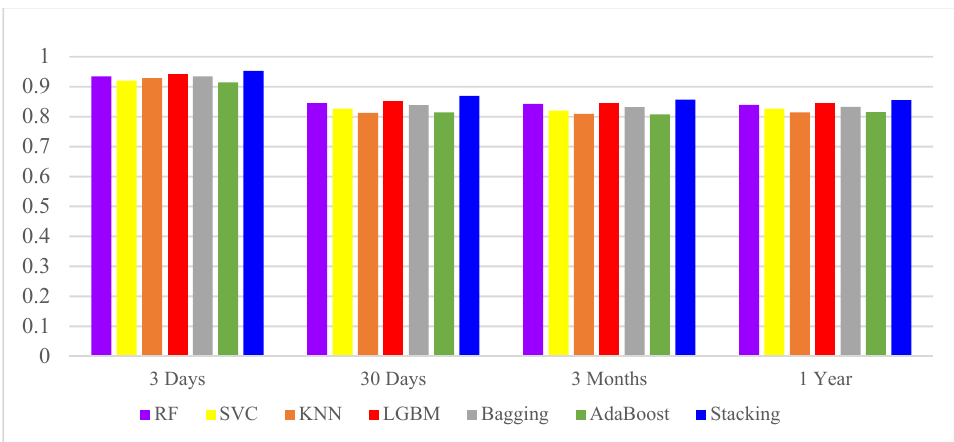
Figure 5. The Accuracy of different classifiers.